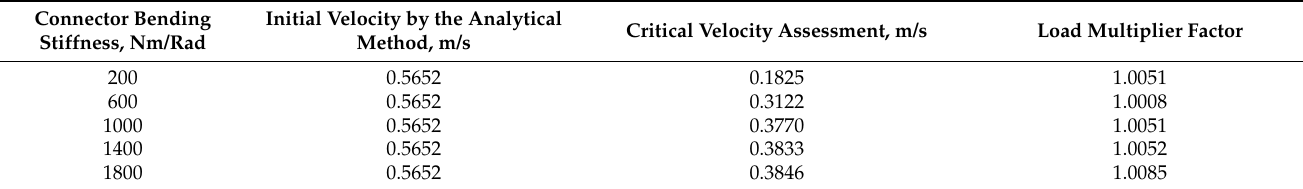
Table 13. The effect of the connector’s bending stiffness on the critical velocity, for the Holding